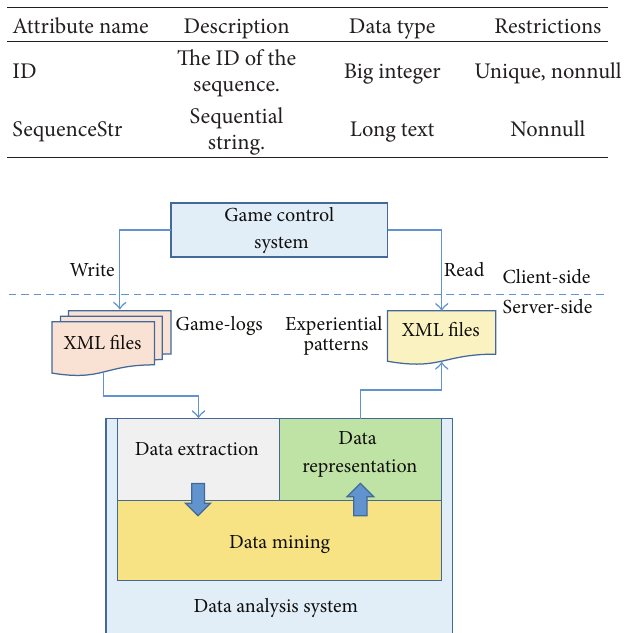
Table 3: Attributes of the CheckerUsage